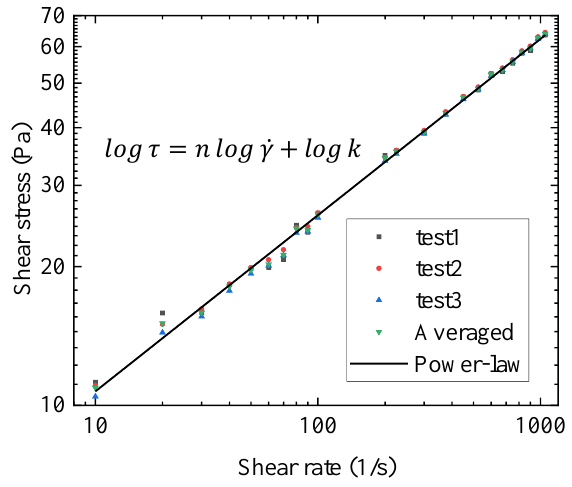
Figure 2. Flow curves of the shear stress vs. shear rate after high-speed shearing. After high-speed shearing, the gel behaves as a power-law fluid, and the power-law model can be used to fit the stress‒shear rate relationship. The fitting process is shown in Appendix E, and the fitting results are good.